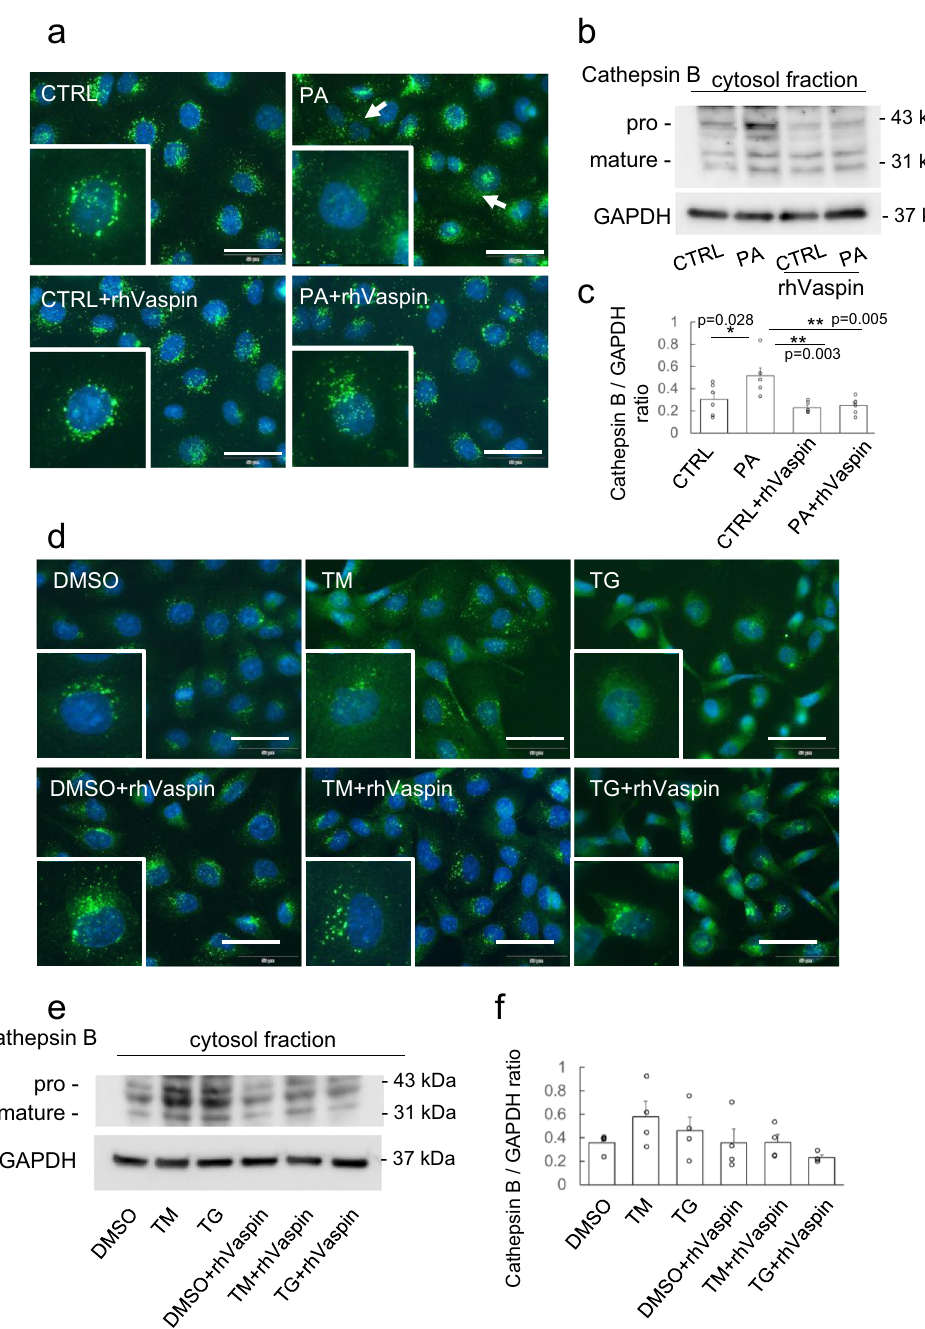
Fig. 3 Cathepsin B leakage into cytosol induced by palmitate-mediated ER stress. a - c HK2 cells were cultured with 500 μ M palmitate (PA) or 0 μ M (CTRL) for 24 h. d - f HK2 cells were treated with DMSO or 1 μ g/ml tunicamycin (TM) or 1 μ M thapsigargin (TG) for 24 h. rhVaspin was administrated at 100 ng/ml for 24 h. The cells were fi xed, permeabilized and stained with anti-cathepsin B antibody (green) with DAPI (blue) ( a , d ). Bar = 50 μ m. The insets show high-power fi elds. Cytosol fraction proteins were isolated and subjected into Western blot analyses of Cathepsin B and GAPDH ( b and e ). Sum of pro- and mature Cathepsin B levels in cytosolic protein are analyzed with one-way ANOVA followed by Tukey – Kramer method ( c and f ). Data are presented as mean ± S.E., n = 4 – 6 independent experiments, * p < 0.05. Western blots and immuno fl uorescence studies were repeated